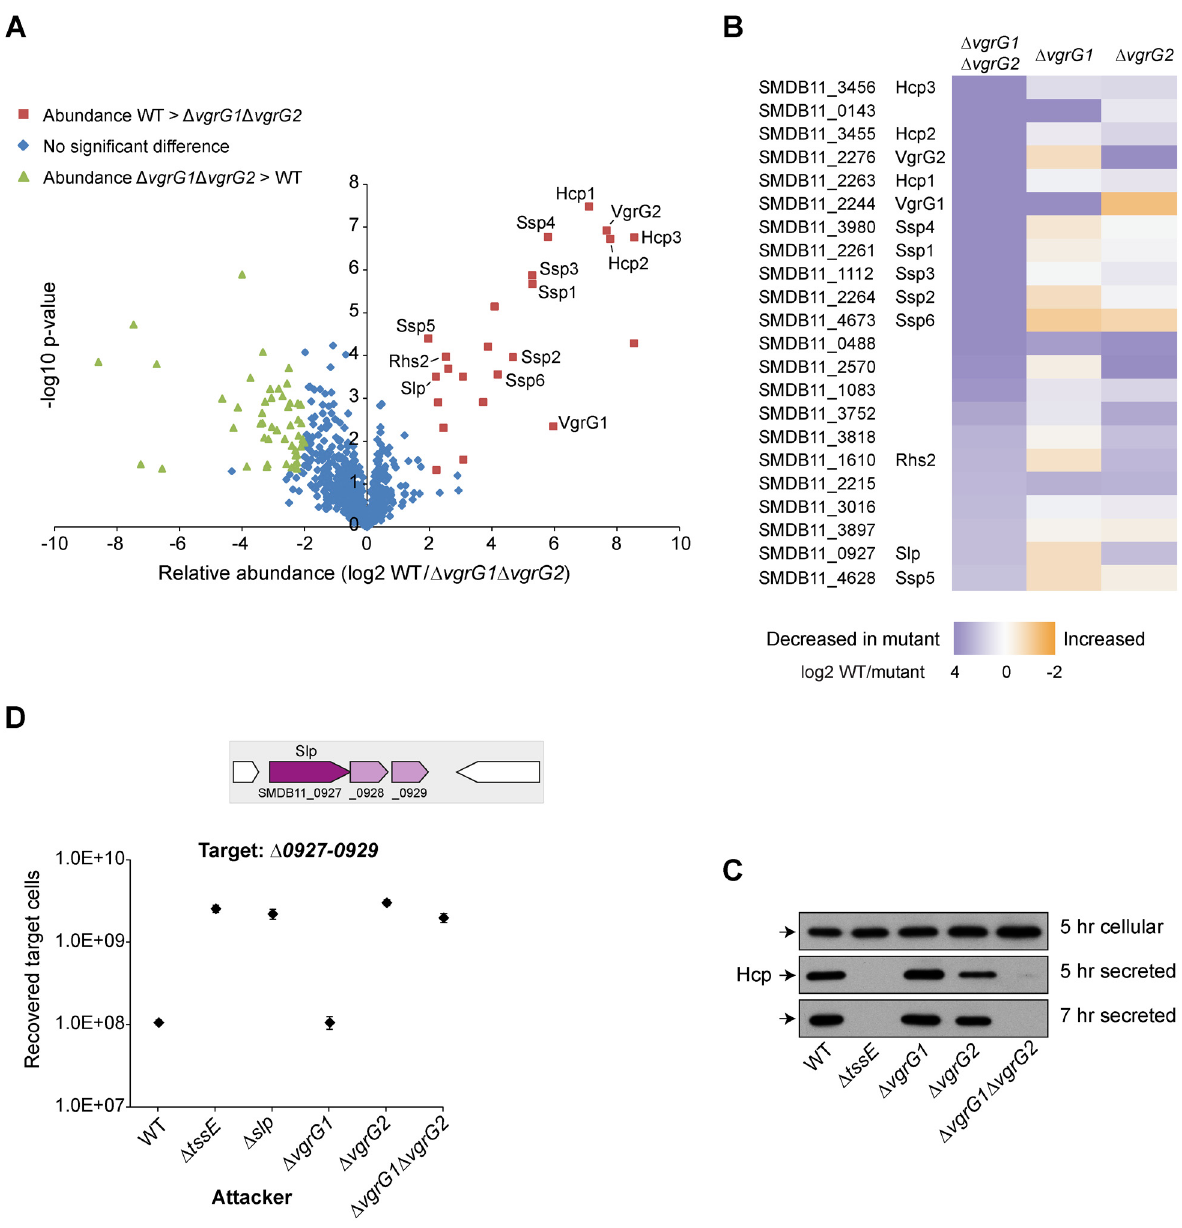
Fig 4. Quantitative secretomics allows comparison of individual VgrG dependence across multiple T6SS substrates and reveals a new VgrG2-specific effector. (A) Volcano plot summarising the secretomic comparison between the wild type (WT) and the T6SS-inactive double VgrG mutant ( Δ vgrG1 Δ vgrG2 ) strains of S . marcescens Db10. The log2 of the ratios of peptide intensities between the wild type and the Δ vgrG1 Δ vgrG2 mutant are plotted against the p-values for label-free quantitation data intensities. Red squares correspond to proteins significantly more abundant in the wild type than the Δ vgrG1 Δ vgrG2 mutant (WT/ Δ vgrG1 Δ vgrG2 > 4; p < 0.05), green triangles to those significantly more abundant in the mutant (WT/ Δ vgrG1 Δ vgrG2 < 0.25; p < 0.05) and blue diamonds to those without significant changes. (B) Heat map illustrating individual VgrG dependences for each of the proteins significantly decreased in abundance in the secretome of the Δ vgrG1 Δ vgrG2 mutant (criteria above and significant ANOVA score overall). Note that proteins significantly increased in the double mutant are not included. (C) Immunoblot detection of secreted Hcp1 after 5 h or 7 h growth for wild type or mutant ( Δ tssE , Δ vgrG1 , Δ vgrG2 and Δ vgrG1 Δ vgrG2 ) strains of S . marcescens Db10. (D) Recovery of a target strain lacking SMDB11_0927 – 0929 ( S . marcescens Db10 Δ 0927 – 0929 ), following co-culture with wild type or mutant ( Δ tssE , Δ slp , Δ vgrG1 , Δ vgrG2 and Δ vgrG1 Δ vgrG2 ) strains of Db10 as attacker. Points show mean ± SEM (n = 4). Inset: genetic arrangement of SMDB11_0927 – 0929 , where SMDB11_0927 encodes the new lipase-like effector, Slp.